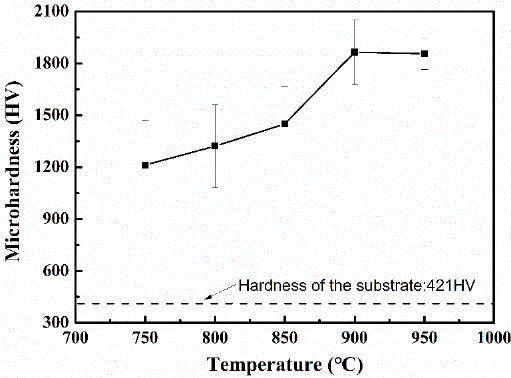
Figure 6. Microhardness of titanium alloy samples at different nitriding temperatures.